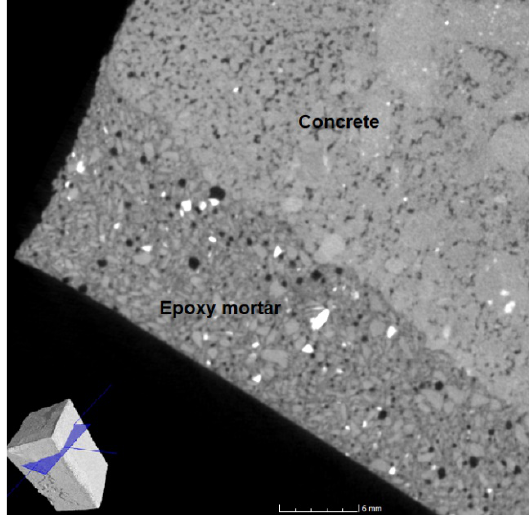
Figure 24. CT scan of the corner reprofiled by the epoxy composite containing the waste glass with the location indicating the scan in the sample.